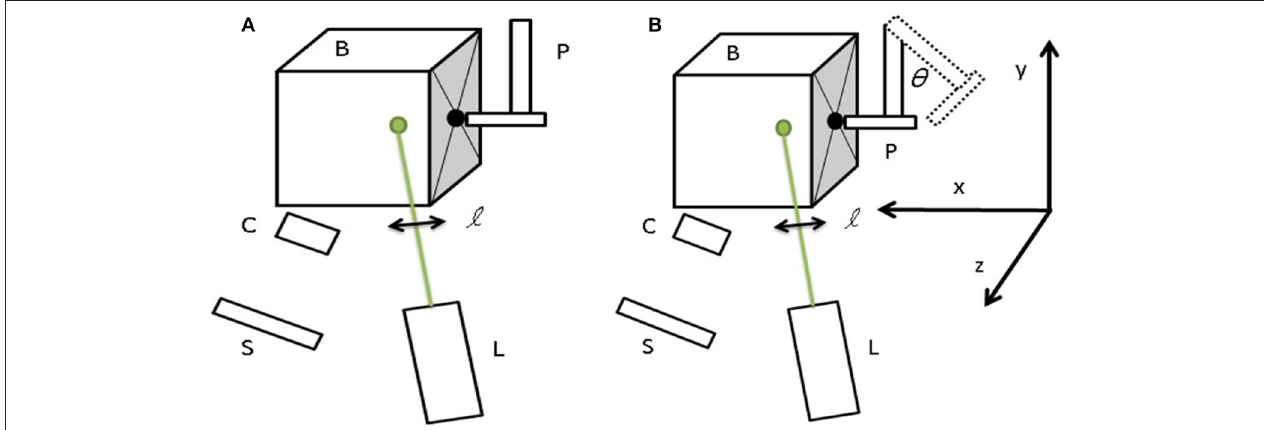
FIGURE 2 | Experimental setup: (A) Sample totally still at t = 0, (B) Characterization of the pendulum impact.